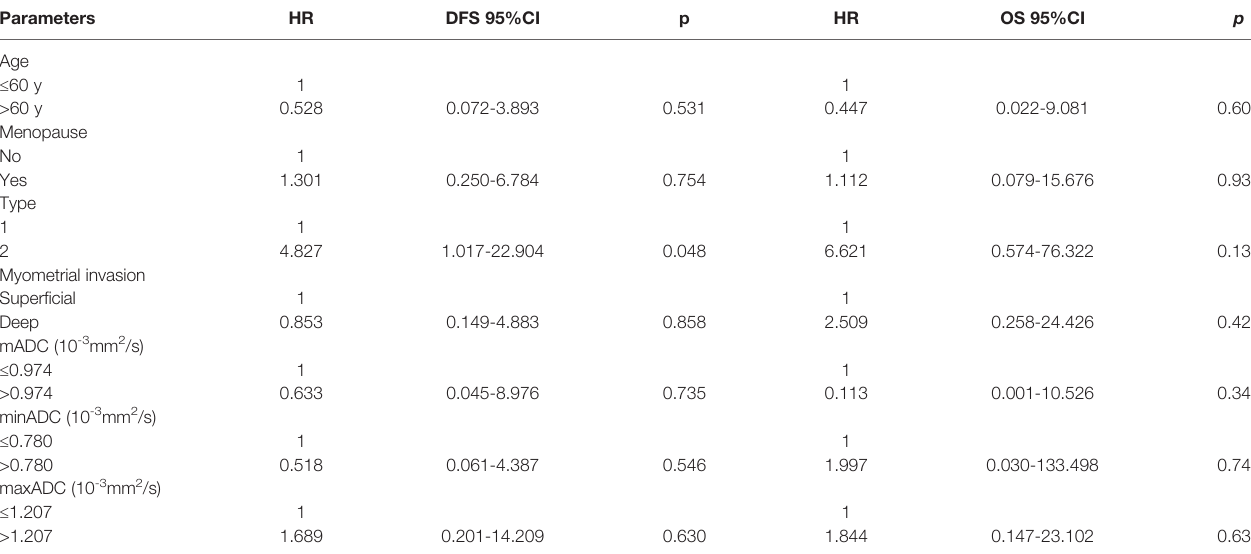
TABLE 4 | Multivariate prognostic analyses.